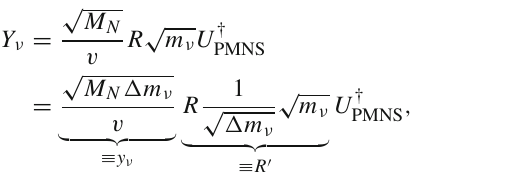
Fig. 1 Freeze-in and freeze-out scenarios in comparison: the left panel comparestwointeractionratestotheHubbleparameter H .Bothofthem are smaller than H for large temperatures since (cid:4) ∼ T for T (cid:5) M and H ∼ T 2 M − 1 and both interaction rates are exponentially suppressed Pl for temperatures T ∼ M , where M is the DM mass. The difference